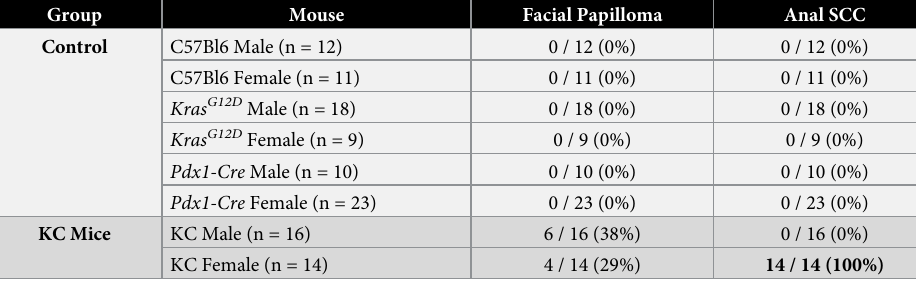
Table 1. Sex-dependent incidence of skin and anal